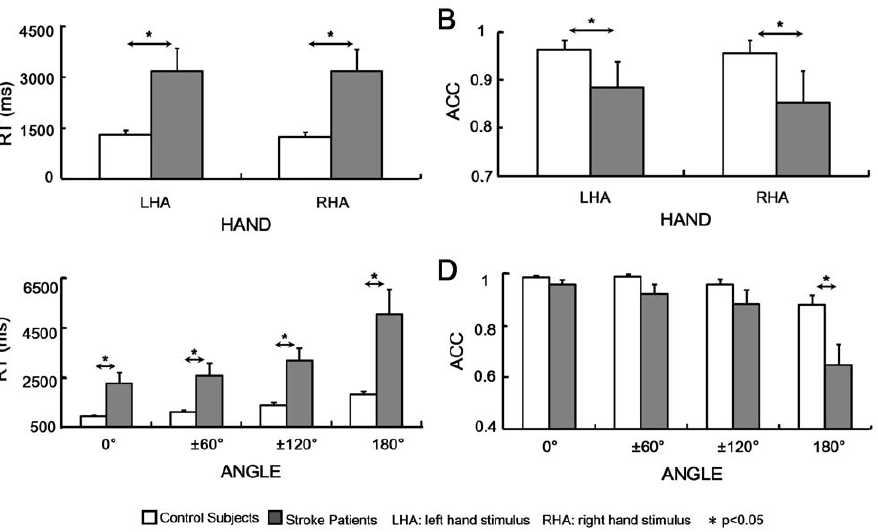
Figure 2. Behavior performance. A and C: Response time was illustrated in aspects of HAND and ANGLE factors respectively. B and D: Accuracy rate was shown also with respect to HAND and ANGLE factors respectively. White bar represented control subjects and gray bar represented stroke patients. Significance was indicated with*.